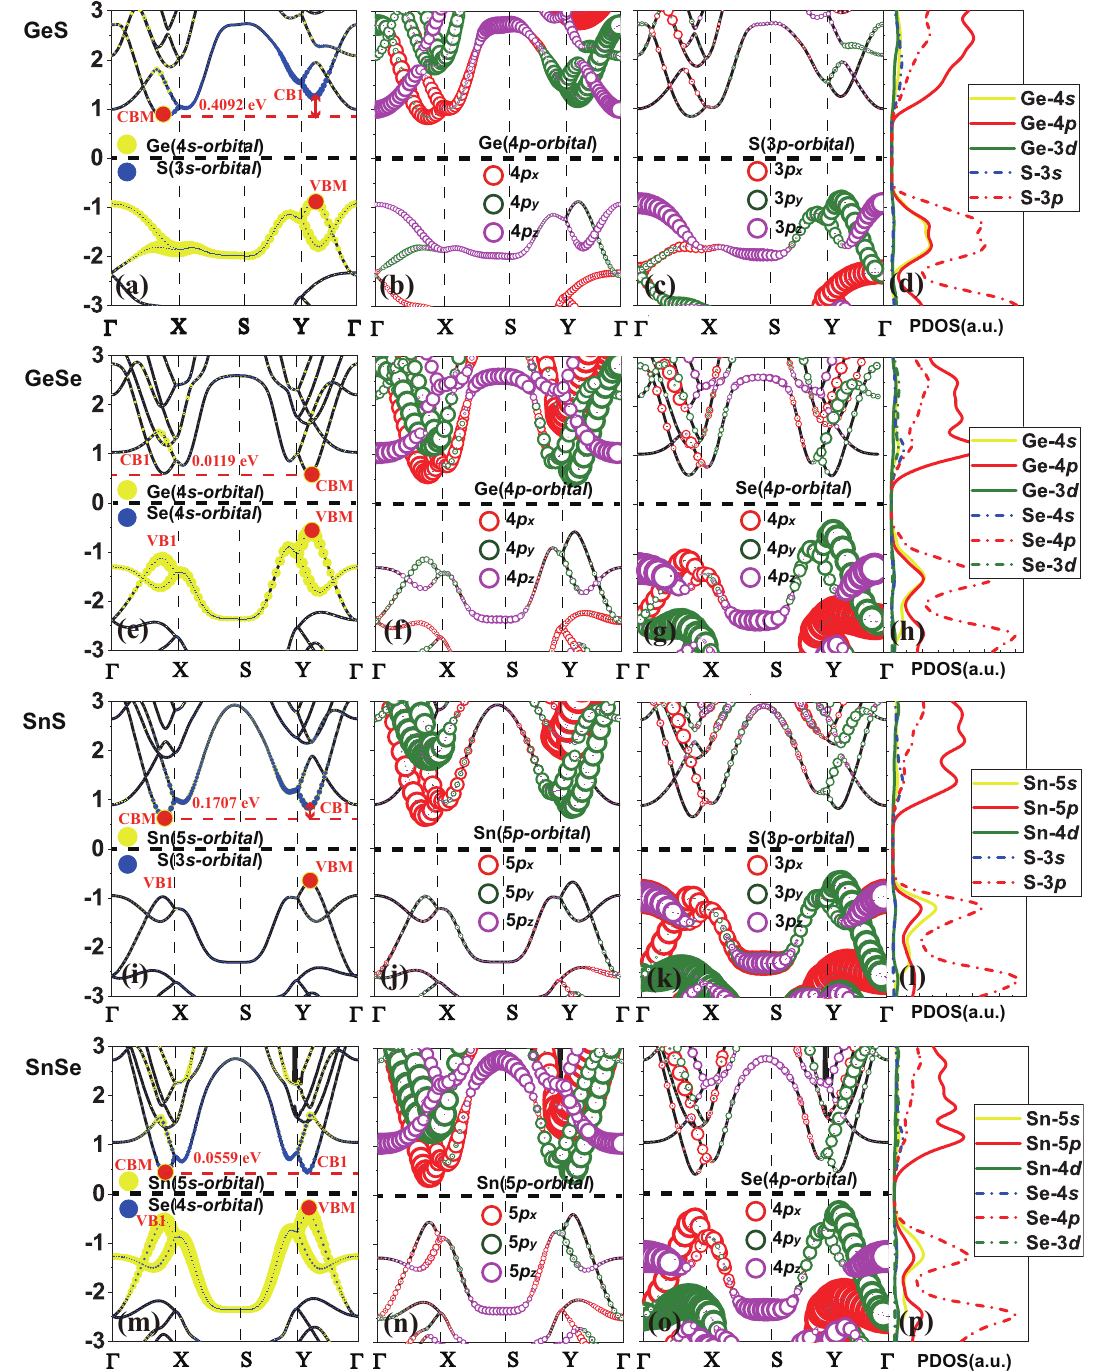
Figure 2. The site and orbital-projected band structure of monolayer GeS ( a – c ); GeSe ( e – g ); SnS ( i – k ) and SnSe ( m – o ). The yellow and blue circles represent s orbitals of M and X atoms, respectively. The red, green and purple circles represent p x , p y and p z orbitals, respectively. Sample size is proportional to the weight of the atomic orbital in corresponding state. In addition, density of states (DOS) of monolayer GeS ( d ); GeSe ( h ); SnS ( l ) and SnSe ( p ). The black lines indicate the band structure. CB1/VB1 is another CBM/VBM with small energy difference from the real